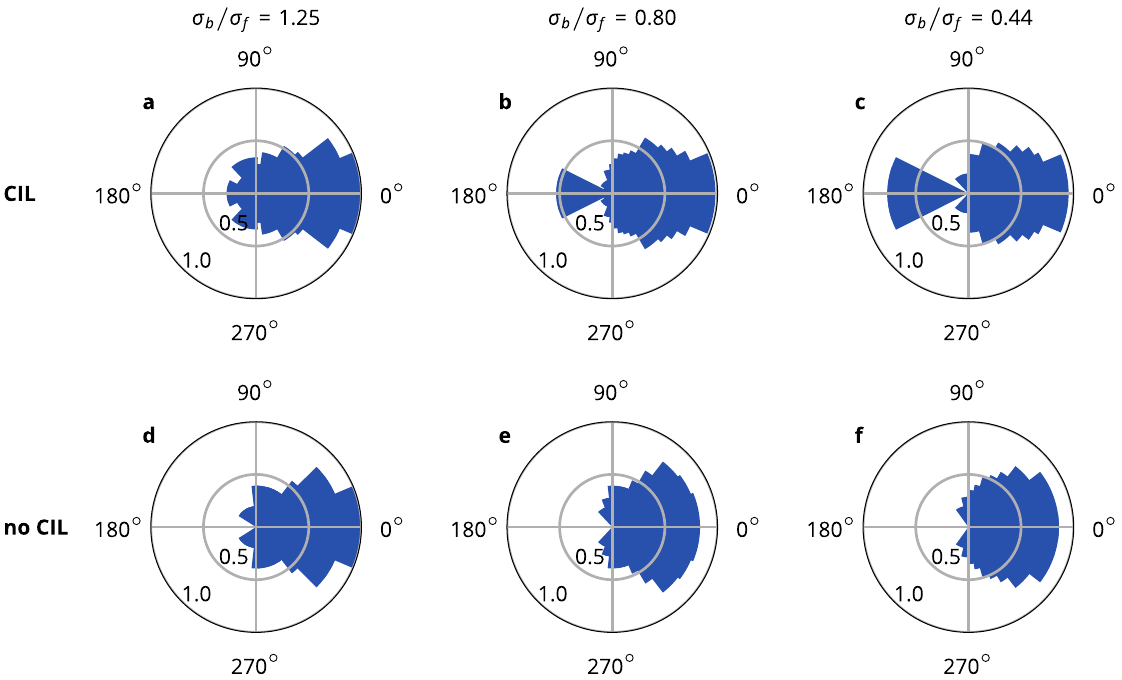
Figure 9. Contact inhibition increases the frequency of back-scattering. Distribution of direction of motion of a cell after a collision with another cell with 0 indicating no change in the direction.